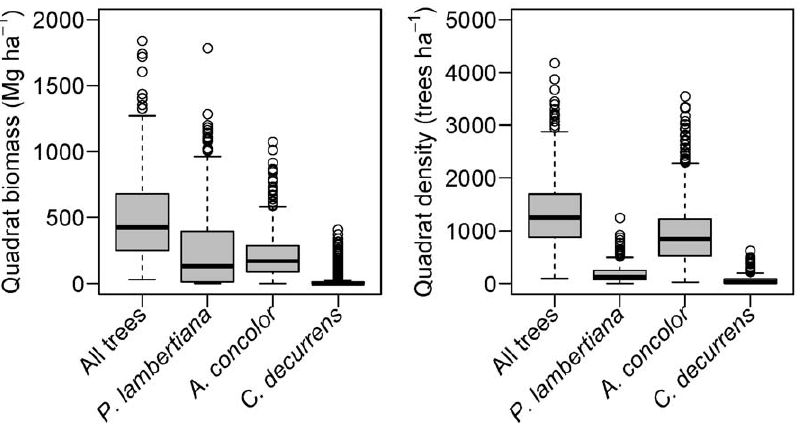
Figure 1. Heterogeneity in biomass and density of the principal tree species of the Yosemite Forest Dynamics Plot. Each boxplot represents values from the 640, 20 m 6 20 m quadrats of the plot.